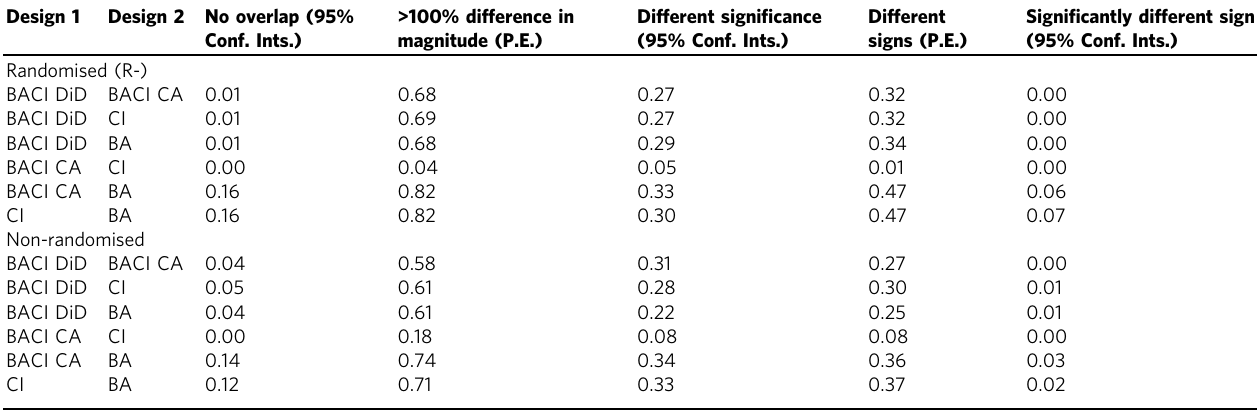
Table 1 Pairwise comparison of estimates obtained using different study designs. Design 1